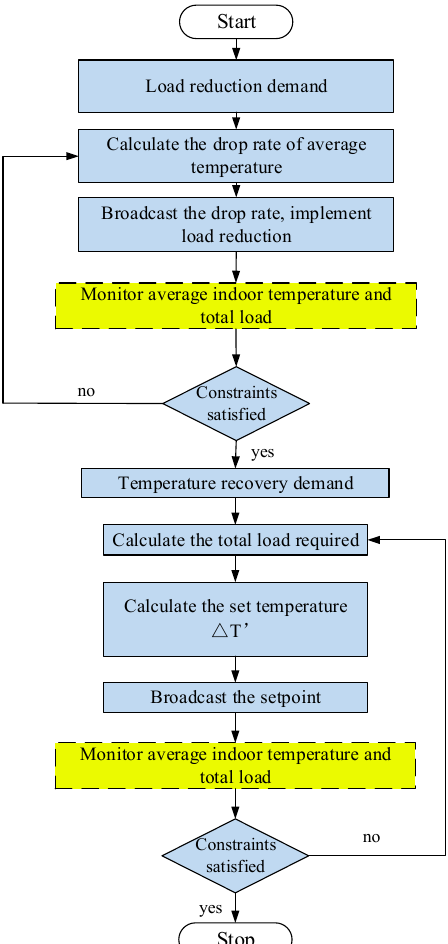
Figure 10. The proposed aggregated load control scheme.